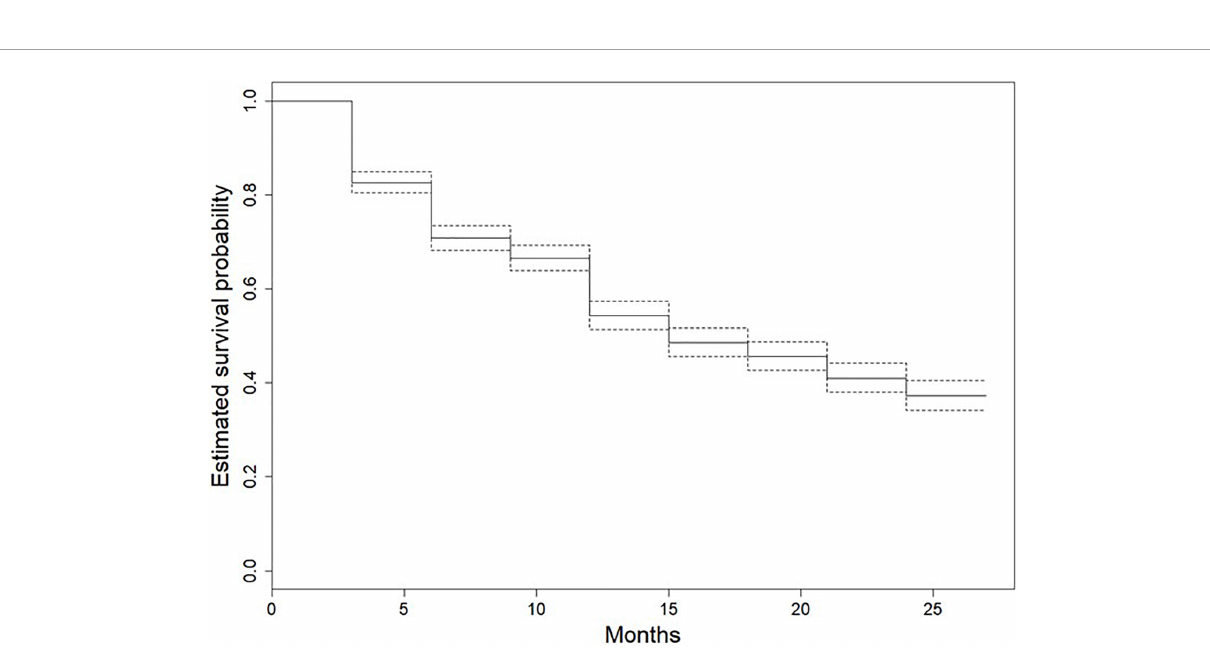
FIGURE4 Estimated survival probabilities of all species seedlings encountered in seedling censuses in the Ngel Nyaki Forest Dynamics Plot from January 2018 to January 2020. Solid line represents estimated survival average probabilities, and the dotted lines show the 95% CI. The survival function was calculated using the Kaplan–Meier